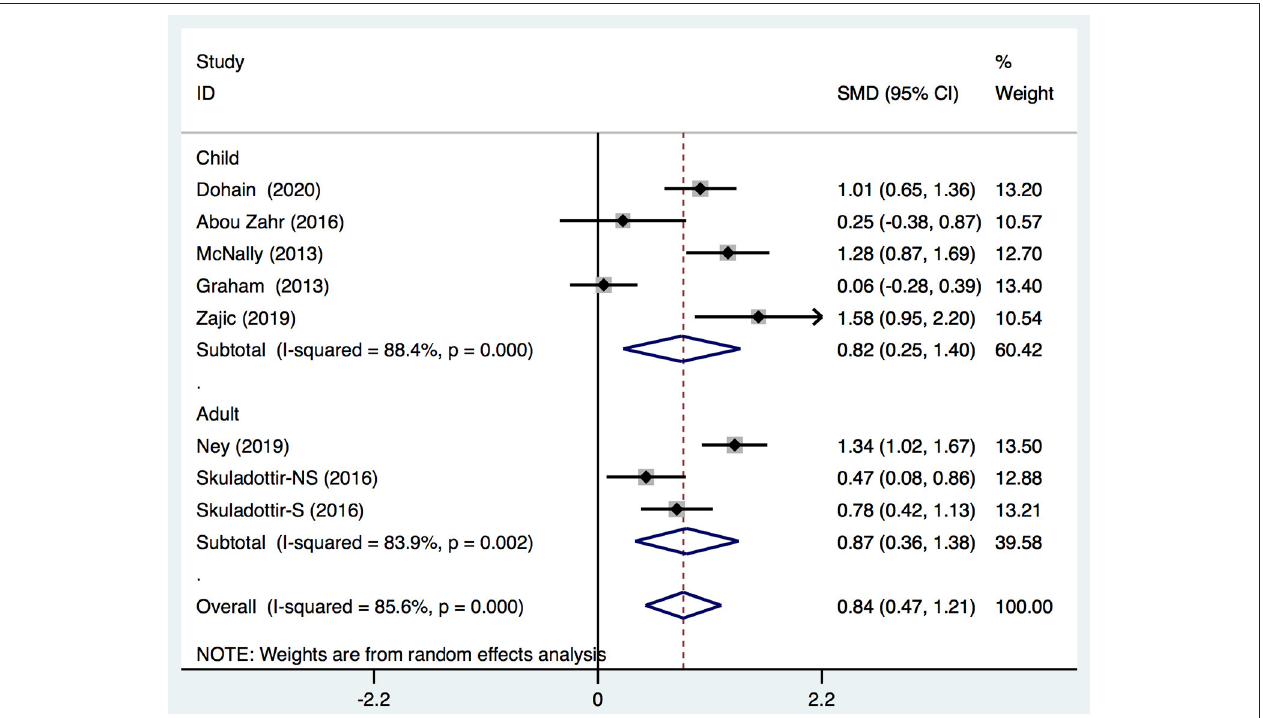
FIGURE 3 | Forest plot for comparison of the VitD level preoperation and 24h postoperation identified in the meta-analysis of eight trials using random-effect model. Only the first author of each study is given. Test for overall effect, z = 4.42, P = 0.000; test for heterogeneity, I 2 = 85.6%, P = 0.000. SMD, standard mean difference. CI, confidence interval.